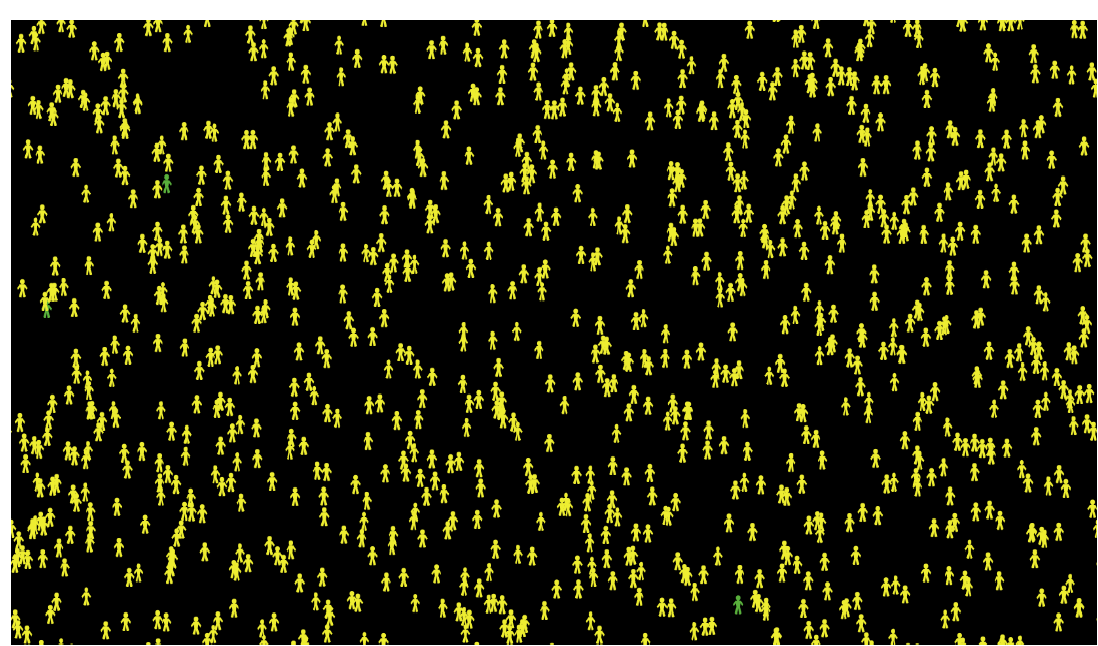
Figure 7. First experiment results of 0% social distancing.